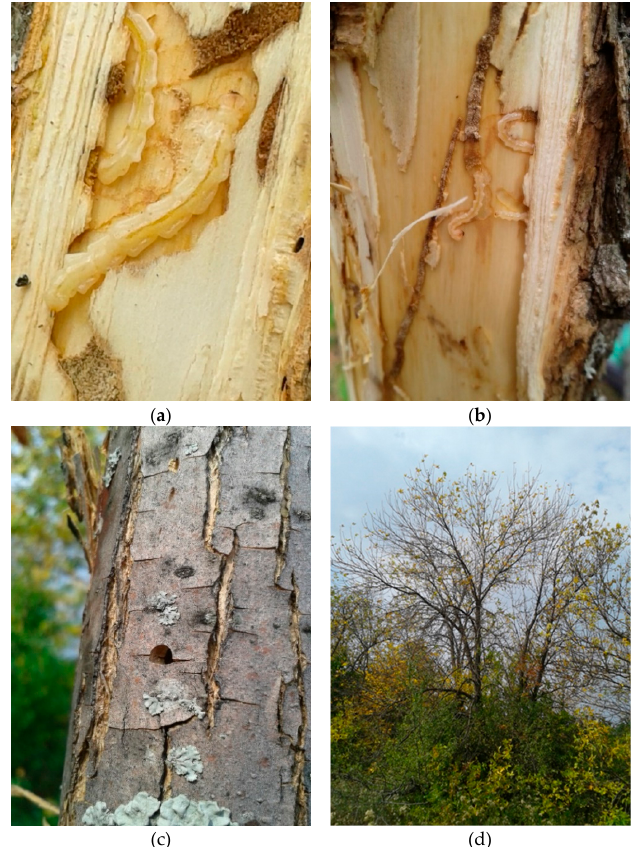
Figure 1. Symptoms of emerald ash borer (EAB) infestation on ash trees ( Fraxinus pennsylvanica ) in the Markivka Disrtict of Ukraine. ( a, b ) Larvae of A. planipennis ; ( c ) exit hole; and ( d ) a damaged tree.